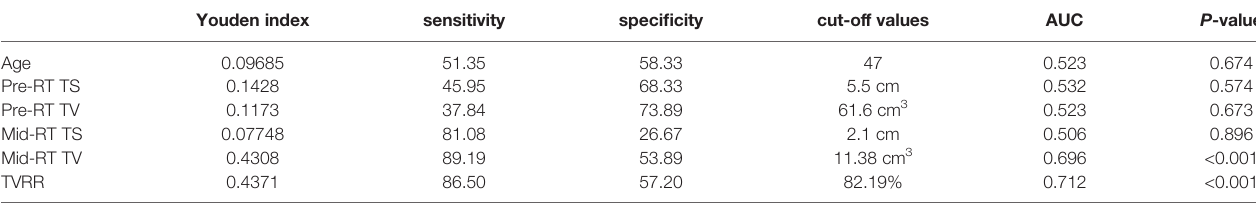
TABLE 2 | ROC relevant parameters and cut-off values.